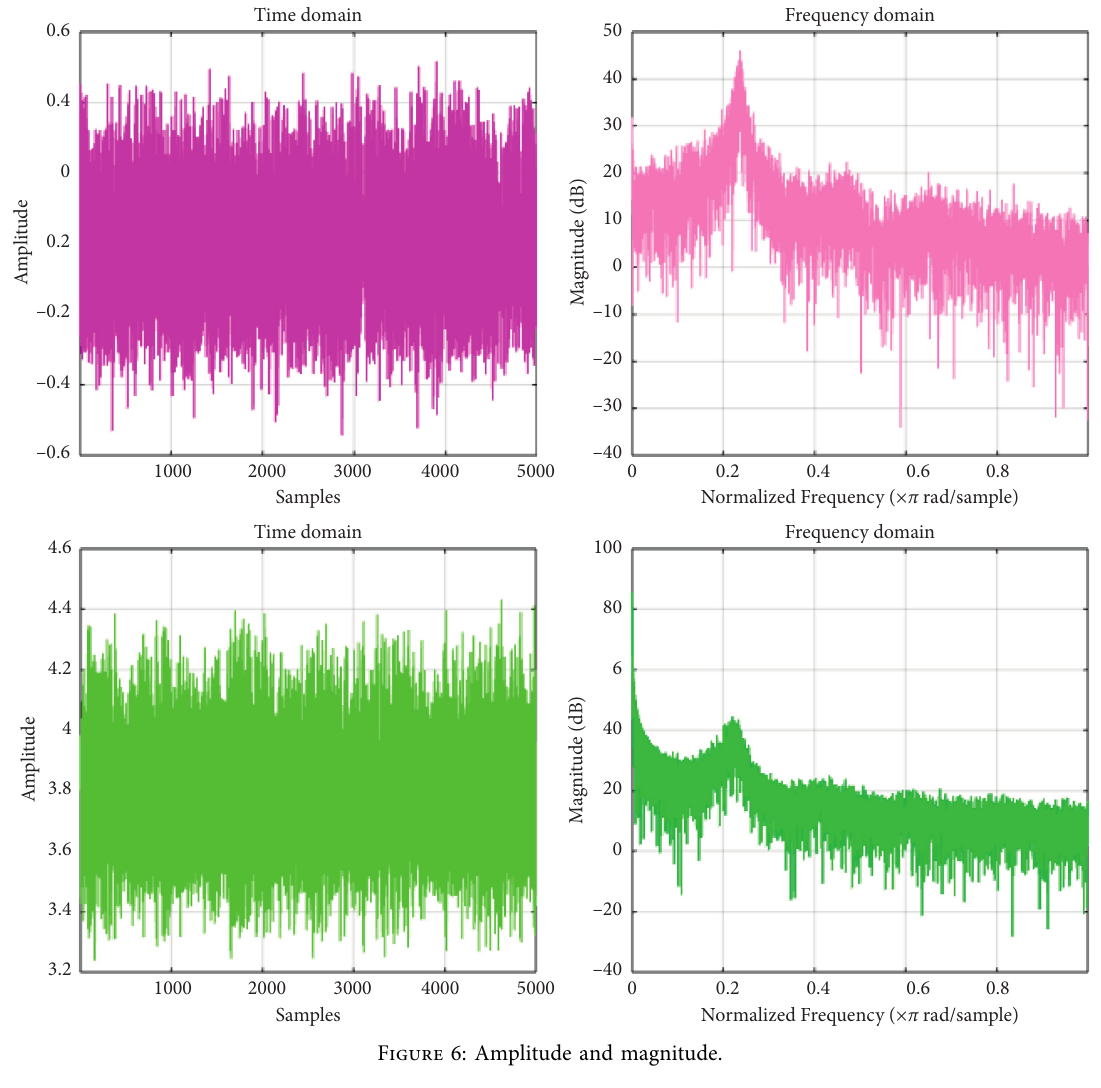
Figure 6: Amplitude and magnitude.